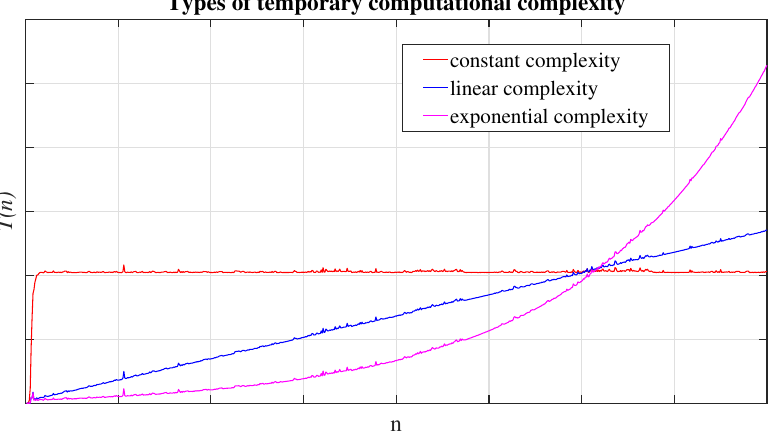
Figure 13. Possible behaviors of the temporary complexity of polynomial and non-polynomial time